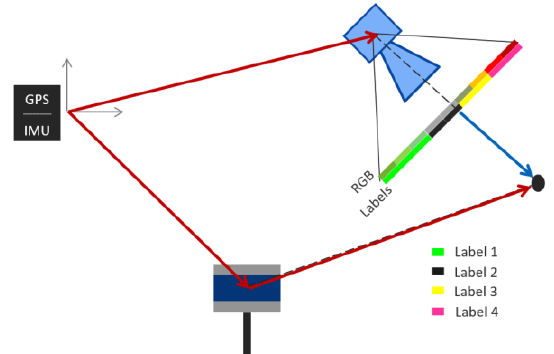
Figure 1. Transferring labels from images to the 3D